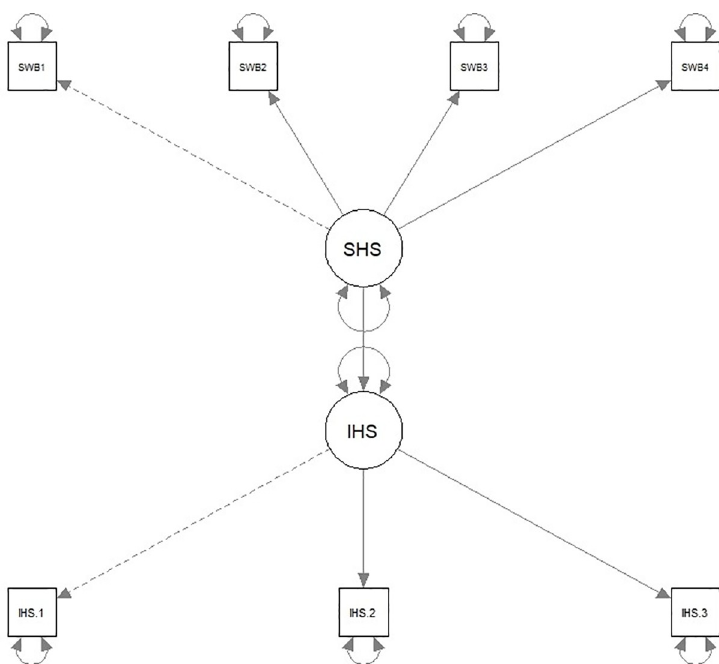
Fig 1. SEM model displaying the correlation between the happiness latent variables. Note . IHS = Interdependent Happiness Scale. SHS = Subjective Happiness Scale. Model fit statistics: RMSEA = .06, CFI = .98, R 2 = .63. Estimate between SHS and IHS: β = .79, b = .31, z = 72.99, p < .001. IHS.1 was an average of the first 3 items on the IHS, IHS.2 was an average of the next 3 items on the IHS, and IHS.3 was an average of the last 3 items on the IHS.